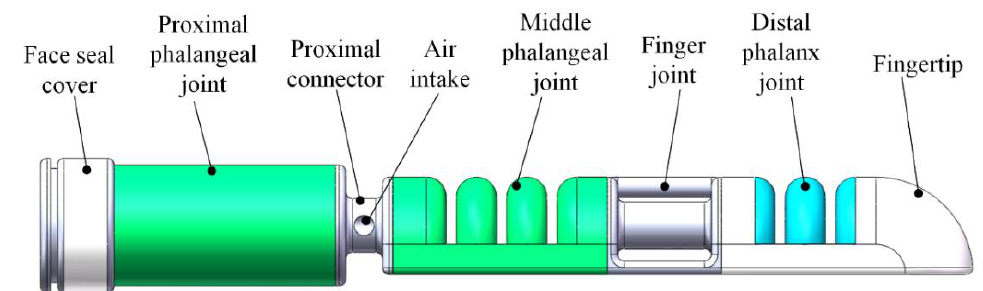
Figure 1. The structure of soft finger.